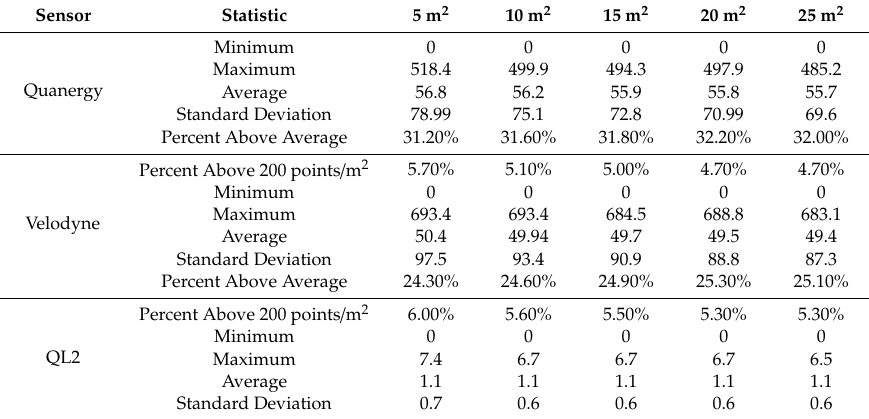
Table 4. Point density (points / m 2 ) statistics for each sensor (Quanergy, Velodyne and QL2 LiDAR) and tessellation size.